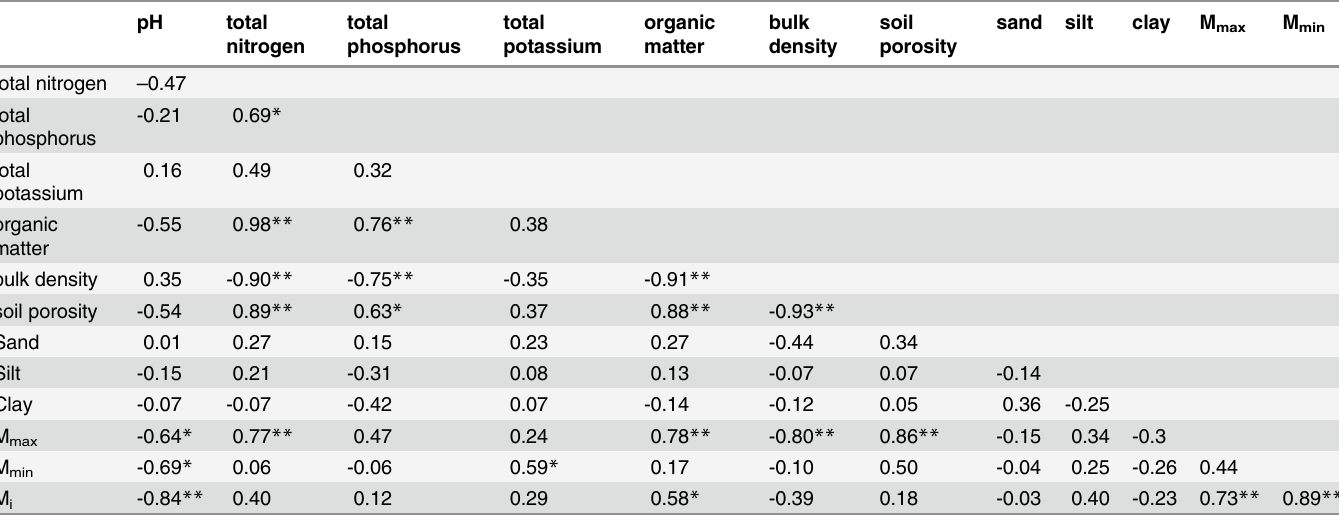
Table 6. Correlations among soil properties and mean soil-moisture